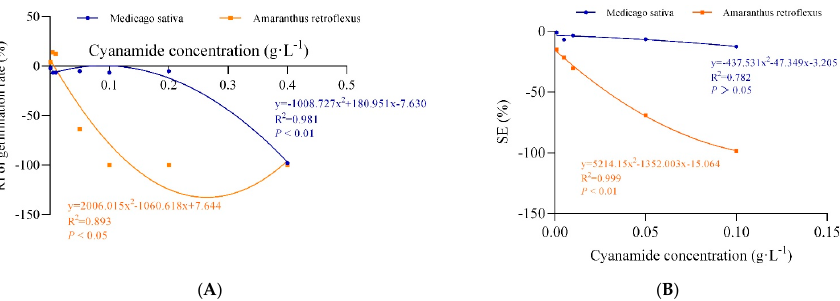
Figure 2. The non-linear fit of response index of germination rate (RI of germination rate) and the synthetical allelopathic index (SE). ( A ) The non-linear fit of response index of germination rate (RI of germination rate). ( B ) The non-linear fit of synthetical allelopathic index (SE).